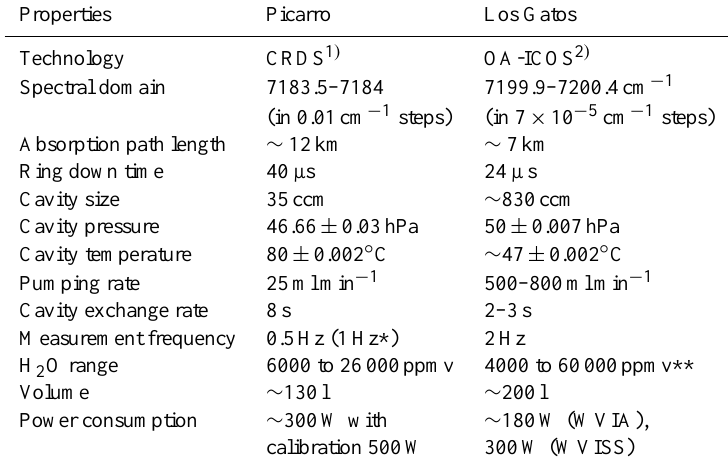
Table 1. Properties and technical details of the L1115-i, L2130-i (Picarro) and the WVIA (Los Gatos) laser systems. The WVIA-EP instru- ment has a smaller cavity than the WVIA, different ring-down times, laser path lengths but similar power consumption